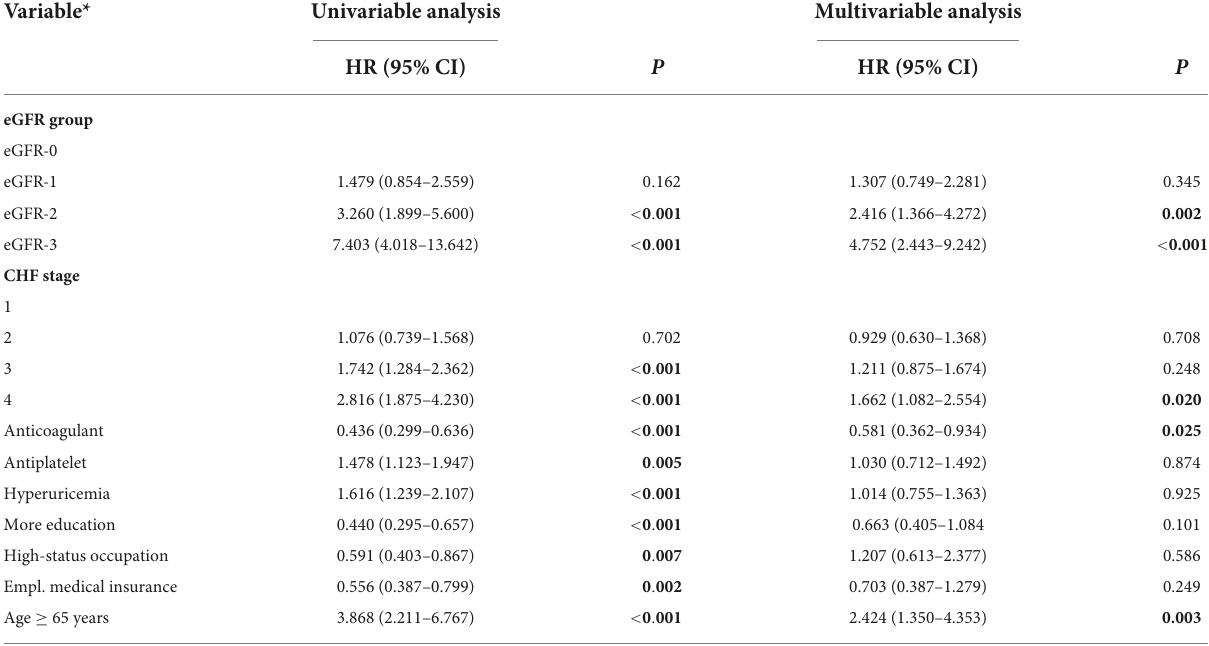
TABLE 2 Univariable and multivariable analysis of factors associated with all-cause mortality in patients admitted for atrial fibrillation.